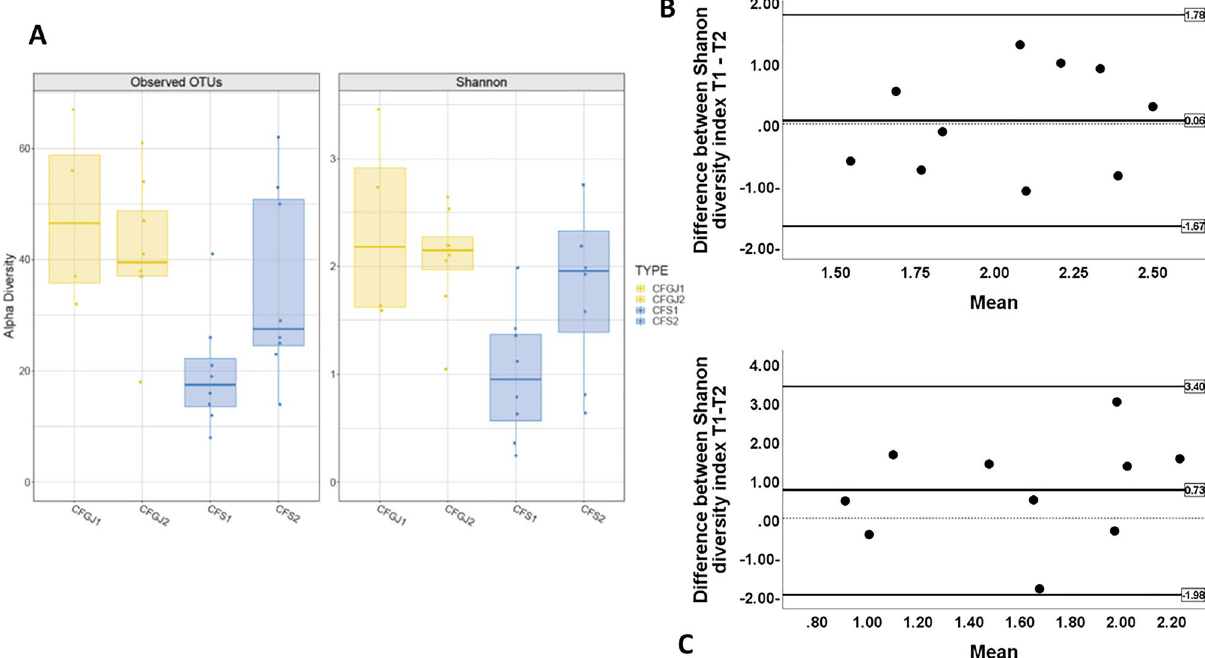
Figure 2. ( A ) Alpha diversity (left) and Shannon diversity index (right) of repeated CF gastric juice (CFGJ) and CF sputum (CFS) samples at the two time points (T1 and T2, n = 10). ( B ) Bland Altman plot of the Shannon diversity index of gastric juice samples (n = 10) from CF patients at 2 time points (T1 and T2). The mean of the Shannon diversity of each subject (x-axis) is plotted against the differences between T1 and T2 (y-axis). Mean difference between T1 and T2 = 0.14 (SD 0.86). ( C ) Bland Altman plot of the Shannon diversity index sputum samples (n = 10) from CF patients at 2 time points (T1 and T2). The mean of the Shannon diversity of each subject (x-axis) is plotted against the differences between T1 and T2 (y-axis). Mean difference between T1 and T2 = 0.72 (SD